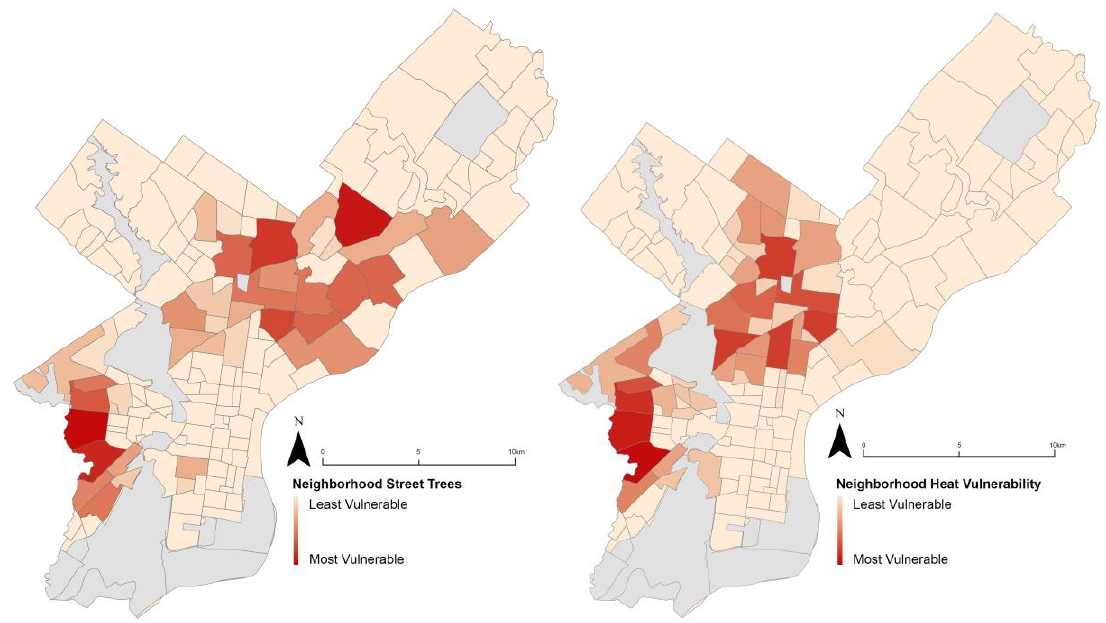
Figure 5. Vulnerability for street trees ( left ) and heat ( right ) by neighborhood. Vulnerability scales from 1 to 25 with lightest colors representing least vulnerable and darkest colors representing most vulnerable as compared to other block groups in the study area. Note: the light gray area represents areas of no data.